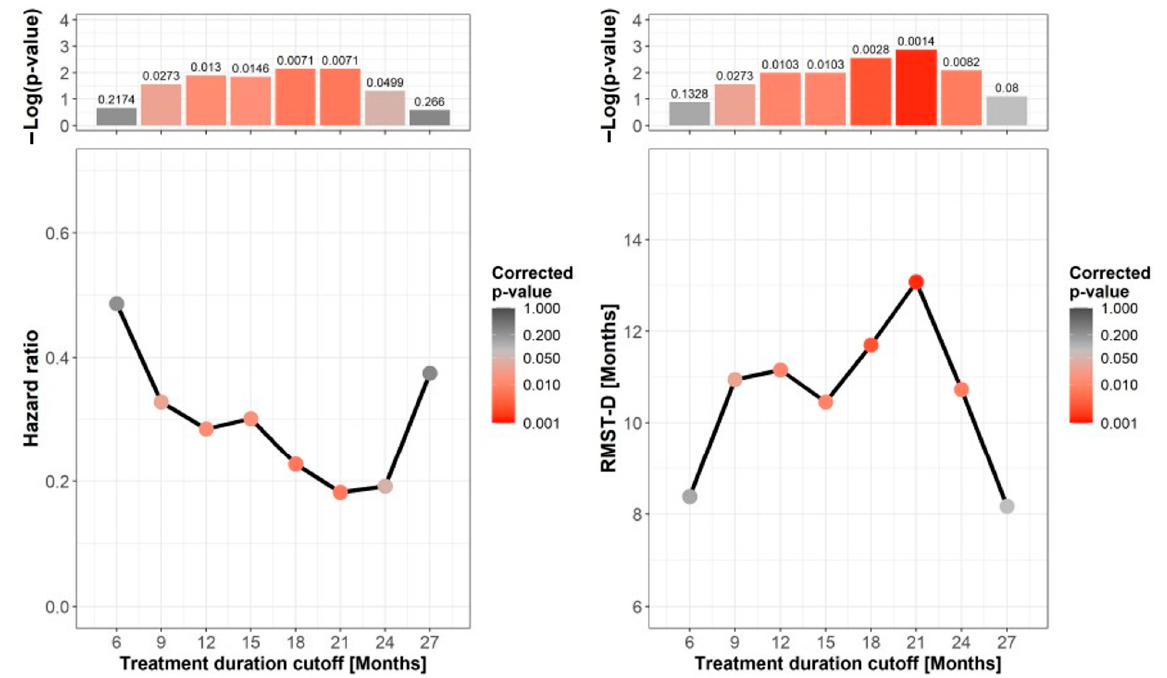
Figure 5. Influence of treatment duration on progression-free survival. Shown are hazard ratio (HR) ( left ) and restricted mean survival time difference (RMST-D) ( right ) for progression-free survival (PFS) of patients with complete response at 3-month time intervals. Each time point represents a duration cutoff that stratifies patients into short or long treatment duration based on the time of treatment discontinuation. The corrected p -values are shown in color and presented as columns at the top panels. The lowest HR for PFS and highest RMST-D with significant p -values were found between 18 and 24 months of treatment durations.